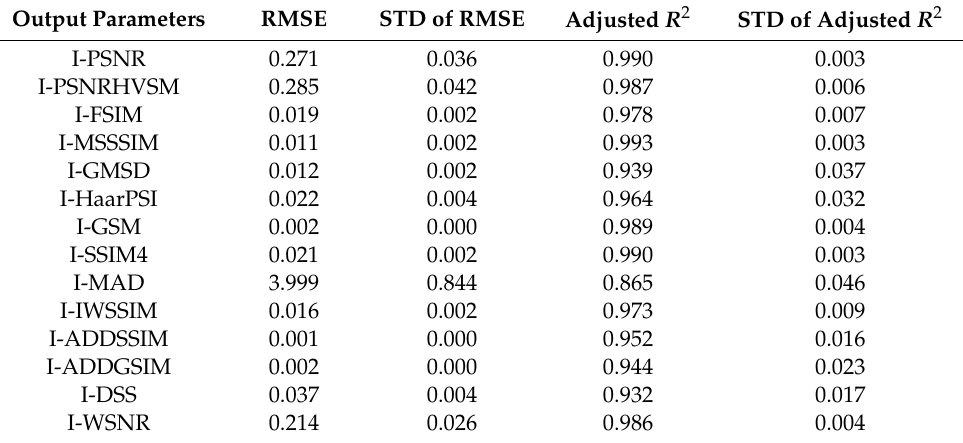
Table 5. Cross-dataset evaluation in the same channel (# 5).